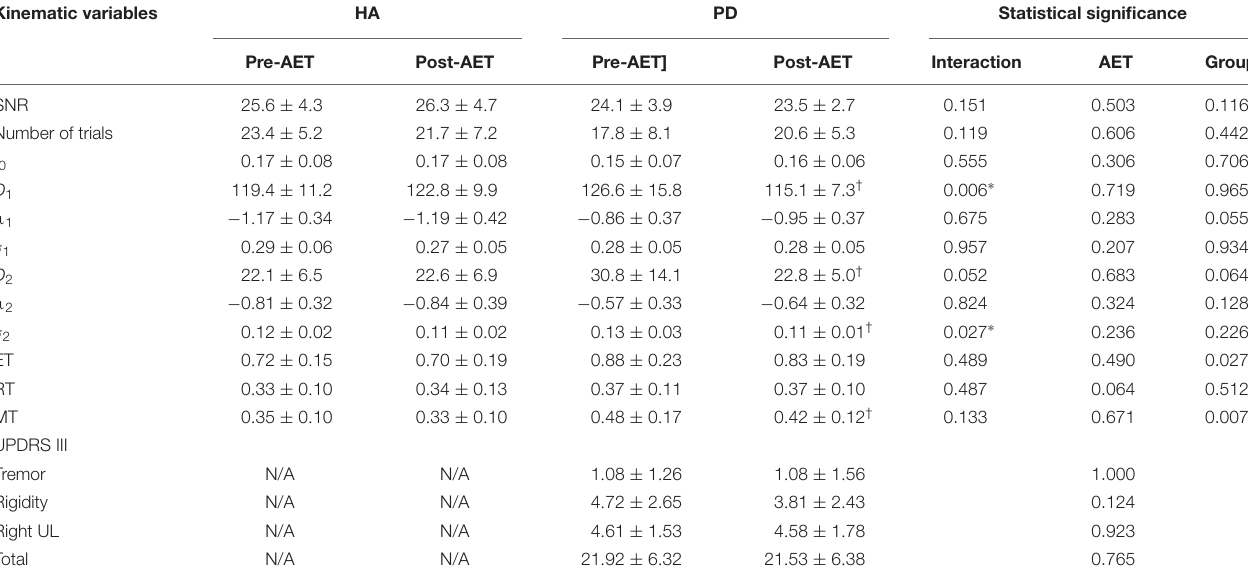
TABLE 2 | Kinetic parameters of the fast simple reaction time task and motor symptoms examination. Kinematic